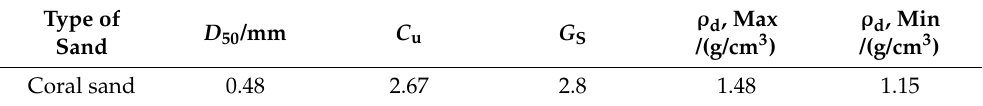
Table 3. Physical properties of the